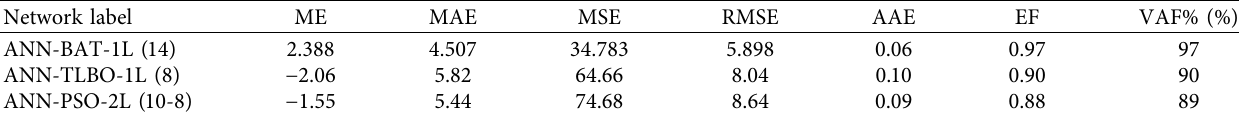
Table 9: Error metrics of top ANNs trained by using BAT, PSO, and TLBO methods on testing data. Network